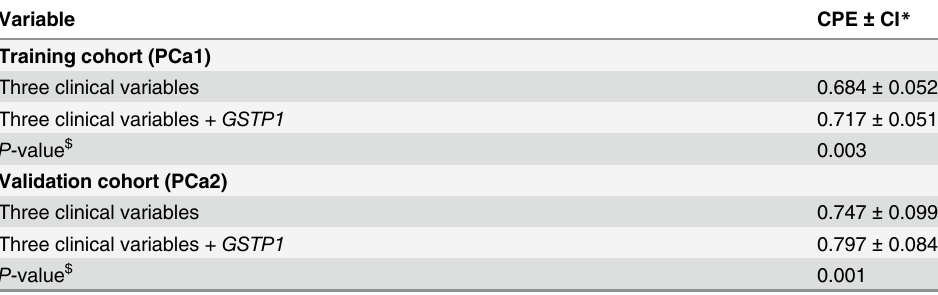
Table 5. Performance of multivariate Cox regression of clinical failure in high risk prostate